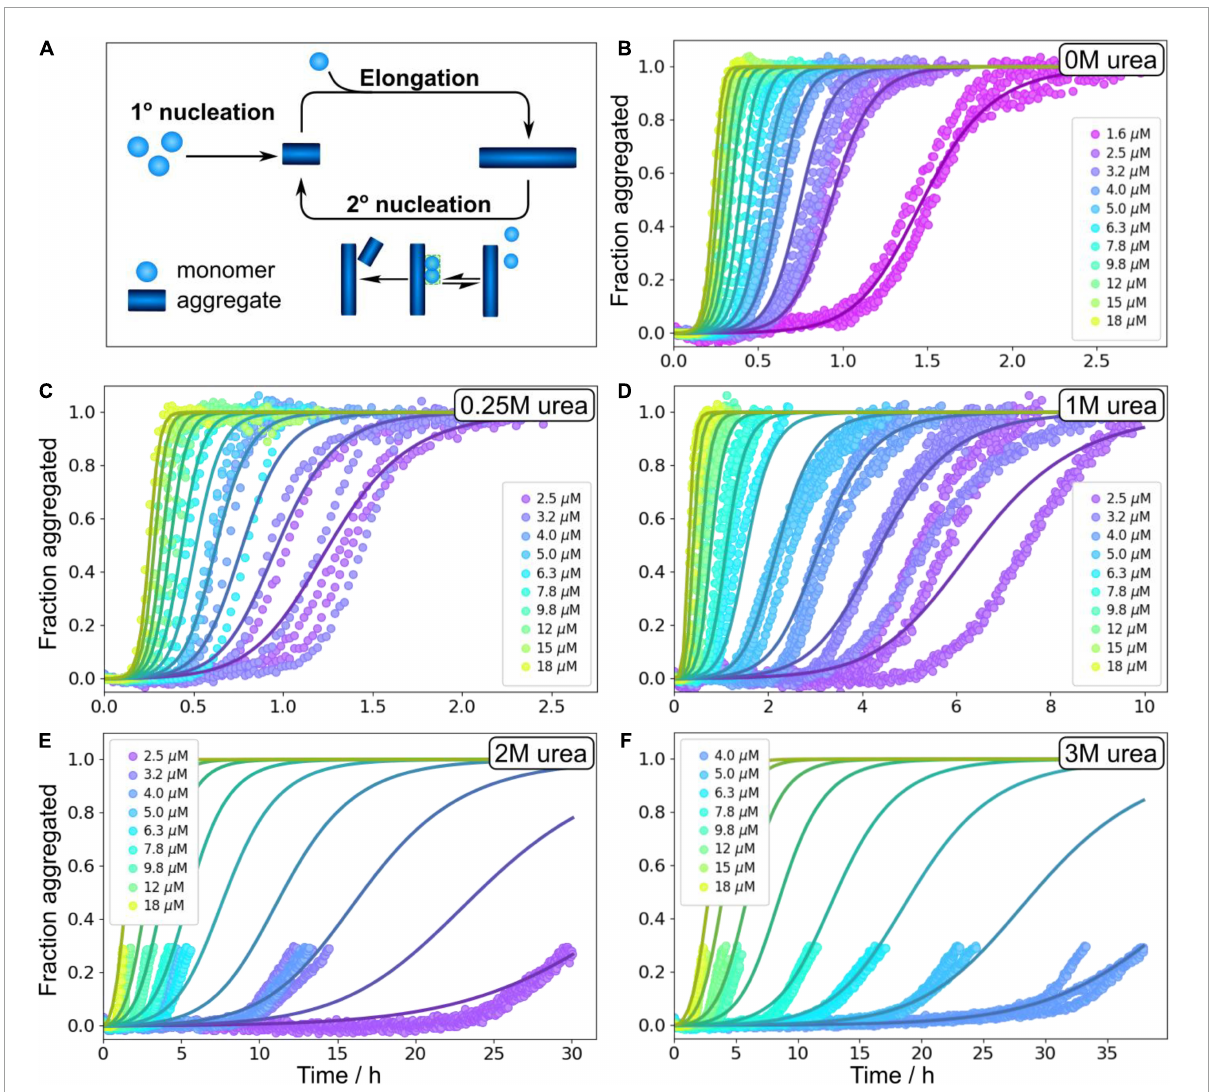
FIGURE4 Global fitting of A β 42 aggregation in urea. (A) Schematic aggregation reaction. A β 42 aggregation is initiated by primary nucleation followed by elongation. New nuclei are also generated through secondary nucleation where an initial attachments step is followed by a conversion/detachment step. (B–F) A β 42 aggregation data in 0 M urea, 0.25 M urea, 1 M urea, 2 M urea, and 3 M urea in 20 mM sodium phosphate, 0.2 mM EDTA, 0.02% sodium azide, pH 8.0 were fitted globally with a model that includes all the steps depicted in panel (A) ,